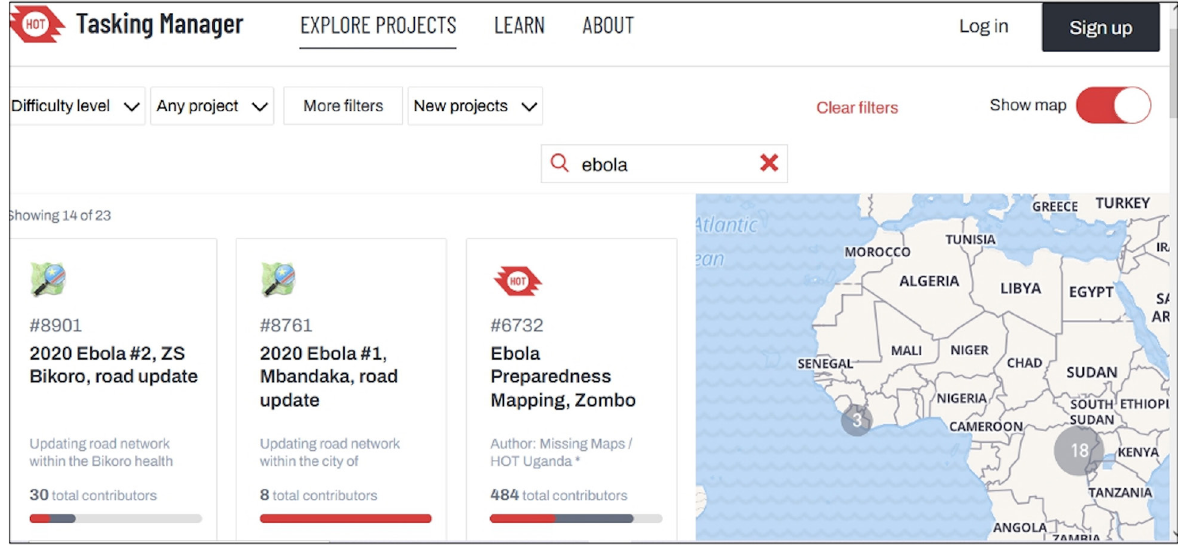
Fig. 8. Mapping improvement Ebola projects carried out by HOT. Source: HOT https://tasks.hotosm.org/explore. HOT – Humanitarian OpenStreetMap